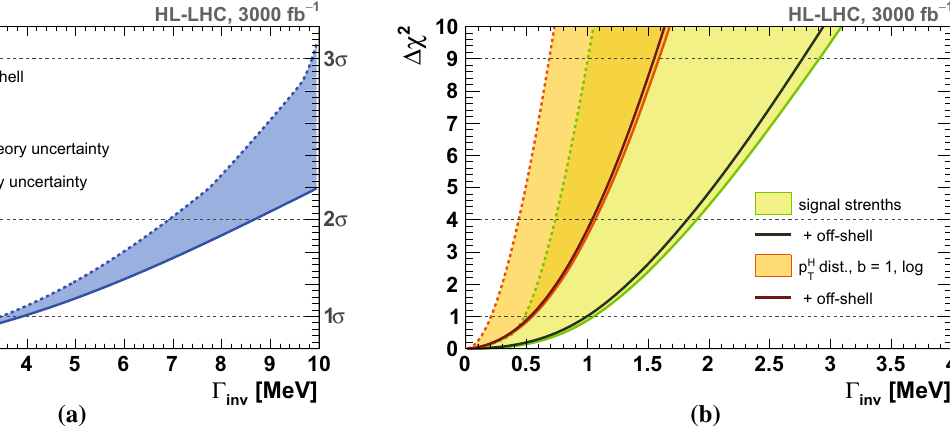
Fig. 4 Higgs width extraction from the off-shell measurement of gg → Z Z . a Limiting the fit to ¯ c g , ¯ c H , ¯ c u 3 and b the overall impact of the off-shell measurement in comparison with the on-shell measure-